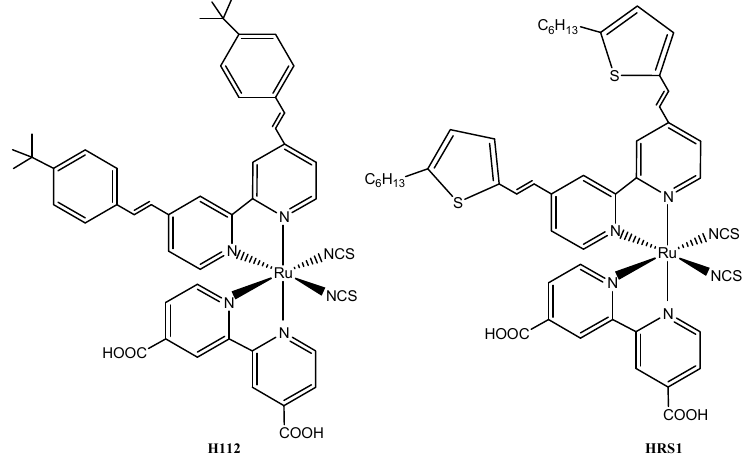
Figure 3. Molecular structures of the ruthenium complexes H112 , and HRS1